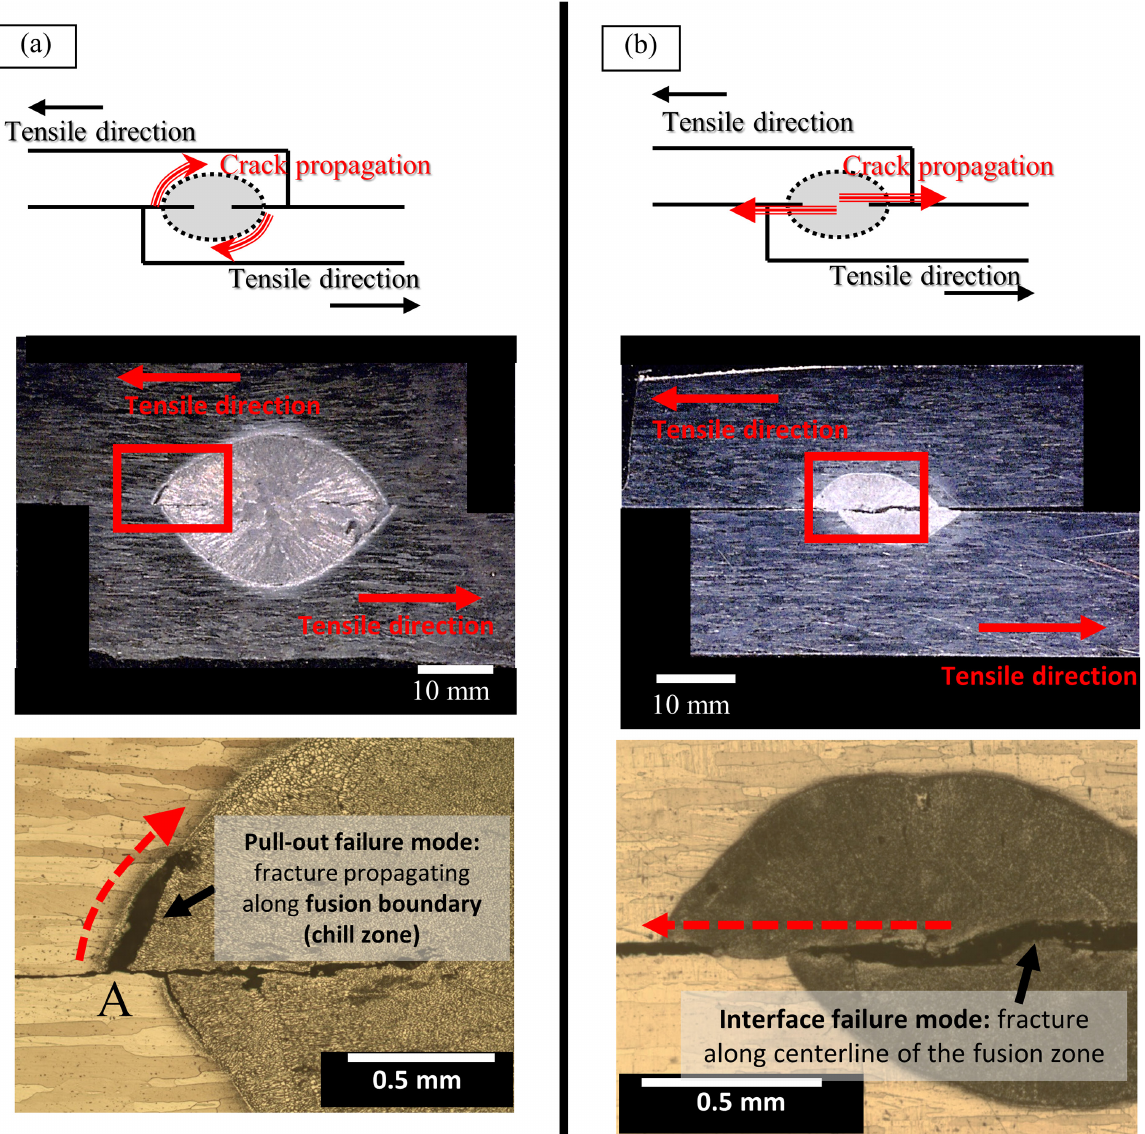
Figure 8: Detailed images of the tensile shear samples: (a) failed in pull-out failure mode; (b) failed in the interface failure